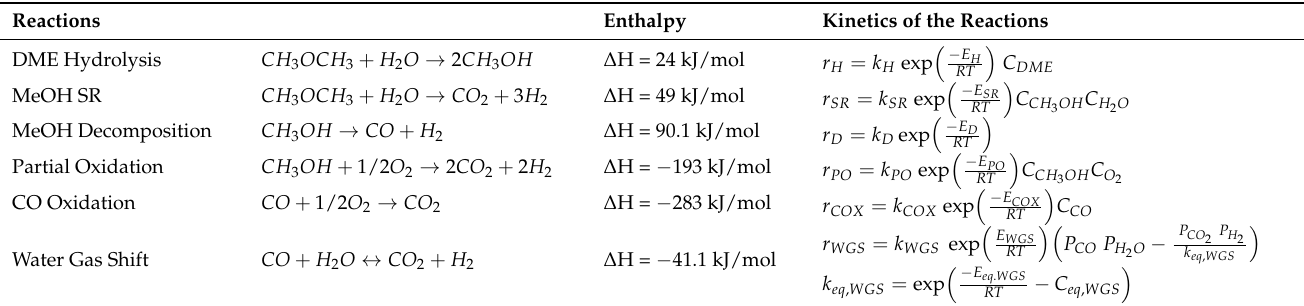
Table 2. Reactions that take place in the DME autothermal